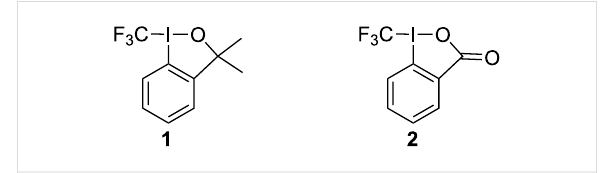
Figure 1: Electrophilic trifluoromethylating agents 1 and 2